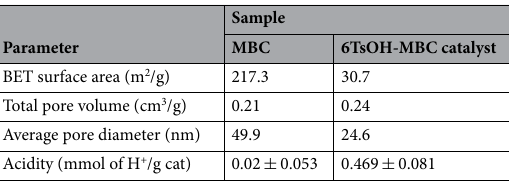
Table 2. Textural characteristics and acidity of MBC and 6TsOH-MBC